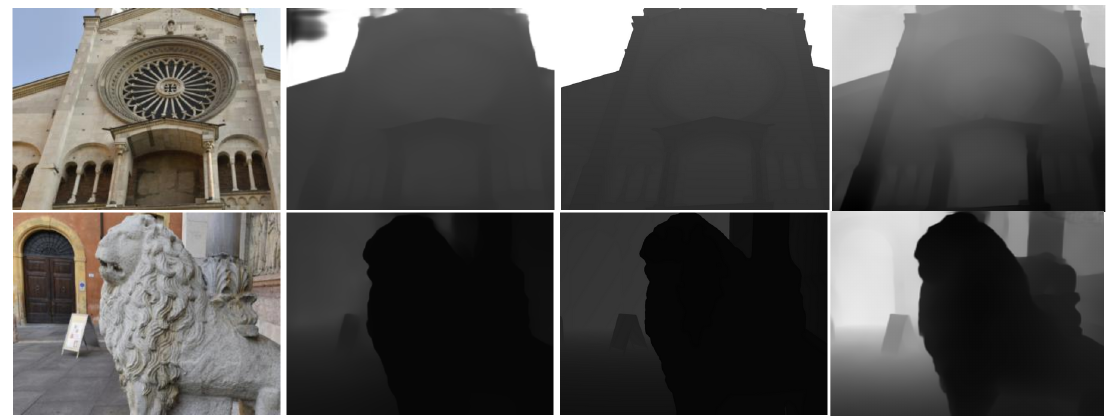
Figure 4. Experiment 2. (a) RGB input image (b) predicted depth map (c) GT depth map (d) LeRes depth map.